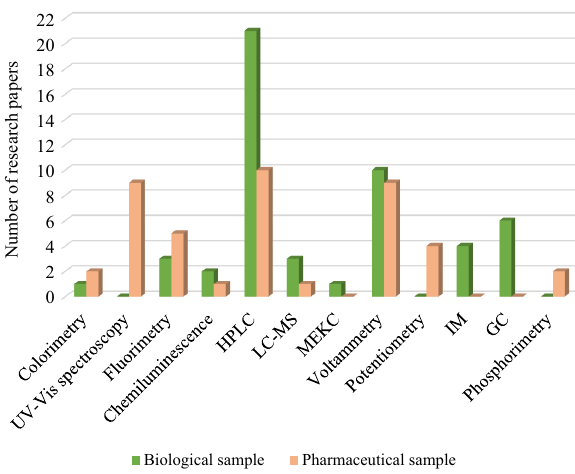
Figure 5: Distribution of analytical methods for INDO determination in relation to type of samples described in the literature in period between 1965 and